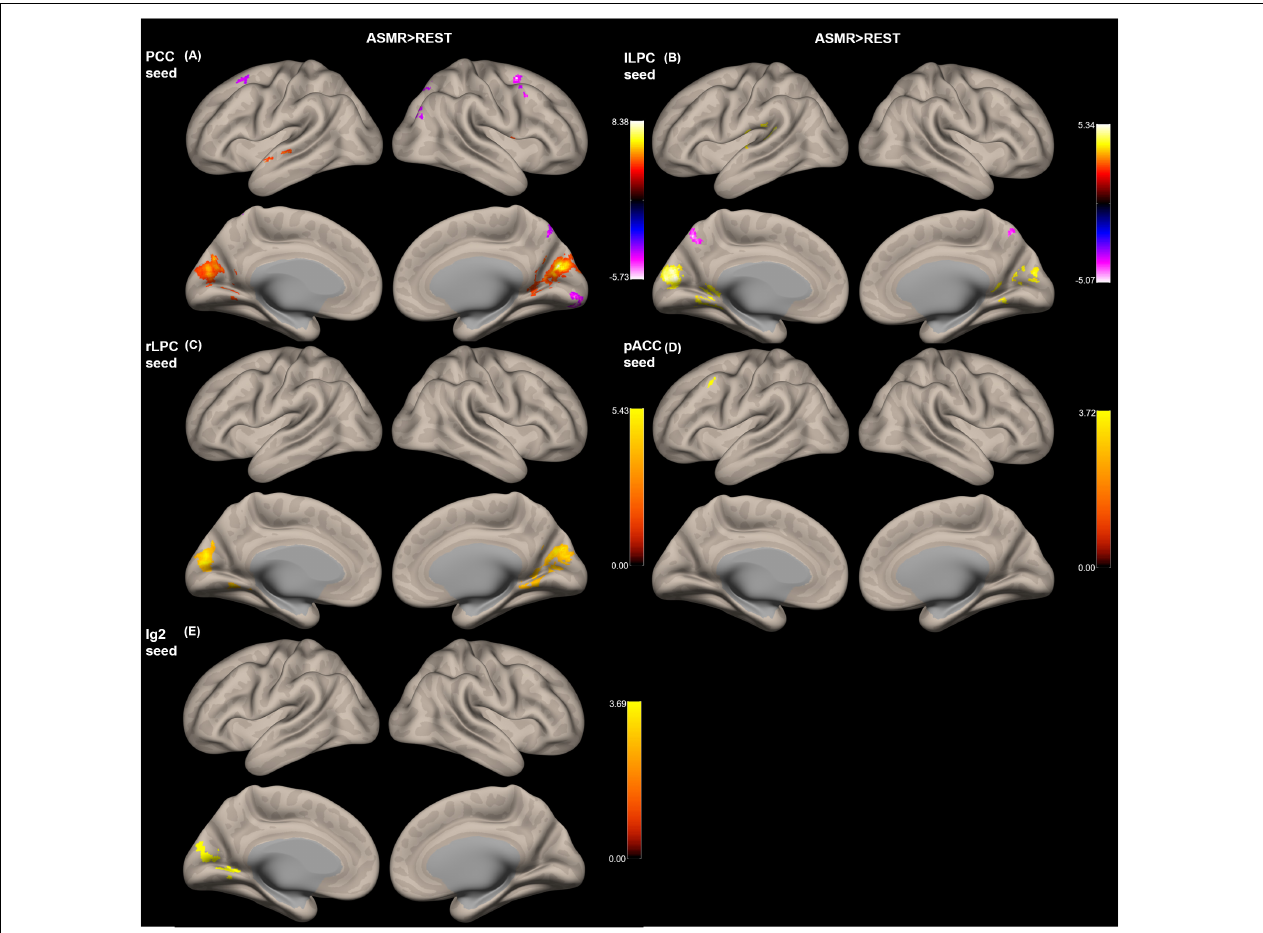
FIGURE 3 | Group-level functional connectivity of the t -statistic obtained by the “ASMR > resting-state” contrast. The default mode networks with seed regions of (A) the posterior cingulate cortex (PCC), (B) left lateral parietal cortex (lLPC), and (C) right lateral parietal cortex (rLPC). (D) The self-network with the pregenual anterior cingulate cortex (pACC) seed region. (E) Affective touch network with the posterior insular cortex (Ig2) seed region. There were no significant clusters in the default mode network with the mPFC seed region and the other-network with the PCC/PC seed